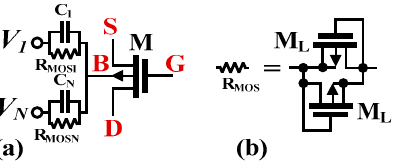
Figure 3. MI-BD MOS transistor ( a ), and realization of R MOS ( b ).